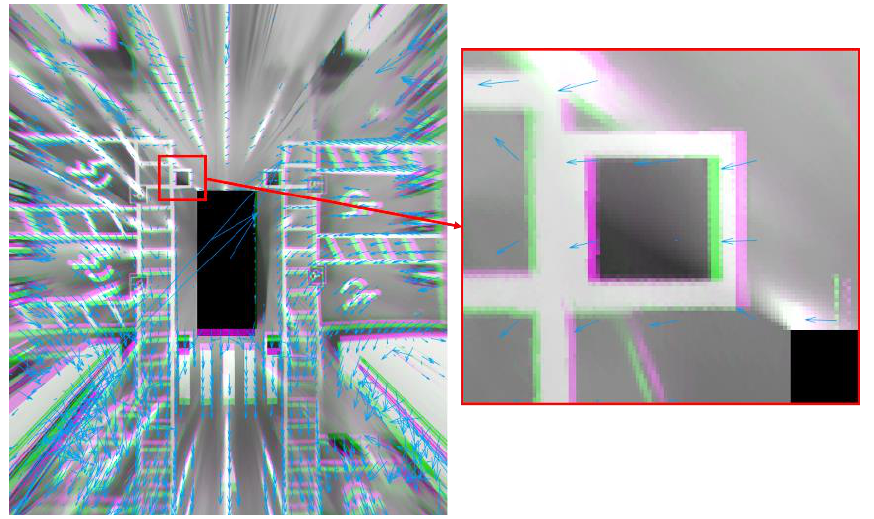
Figure 18. The optical flow between the AVM images of the proposed method and the conventional